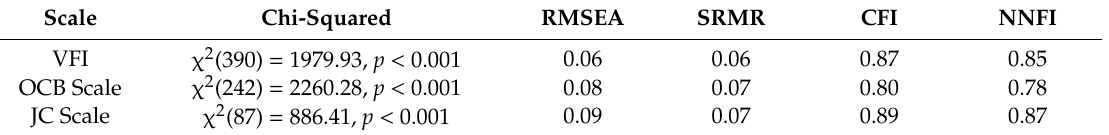
Table 2. Indices of adaptation of the three instruments.